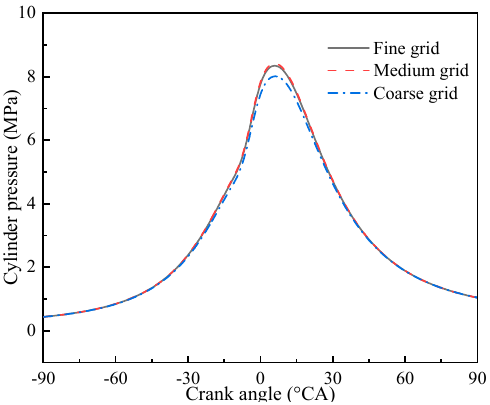
Figure 2. The cylinder pressure comparison of grid independent test.